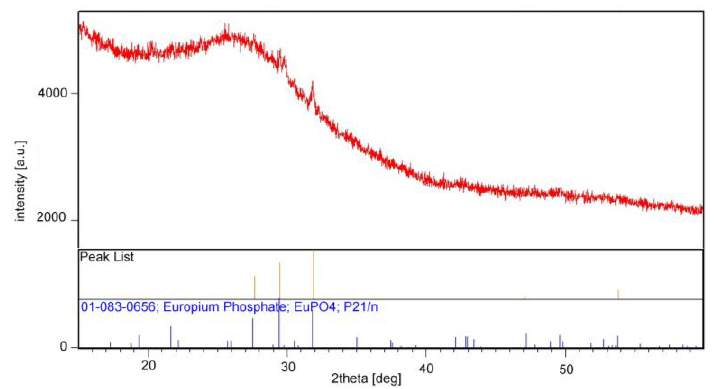
Figure 4. XRD patterns of SGS5P glass sample.